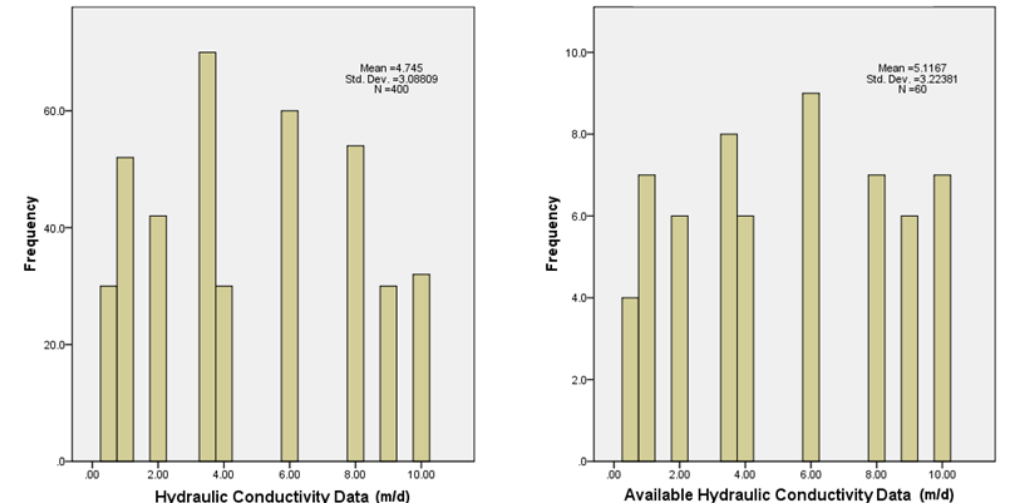
Figure 3. Histogram of hydraulic conductivity data (m/day).